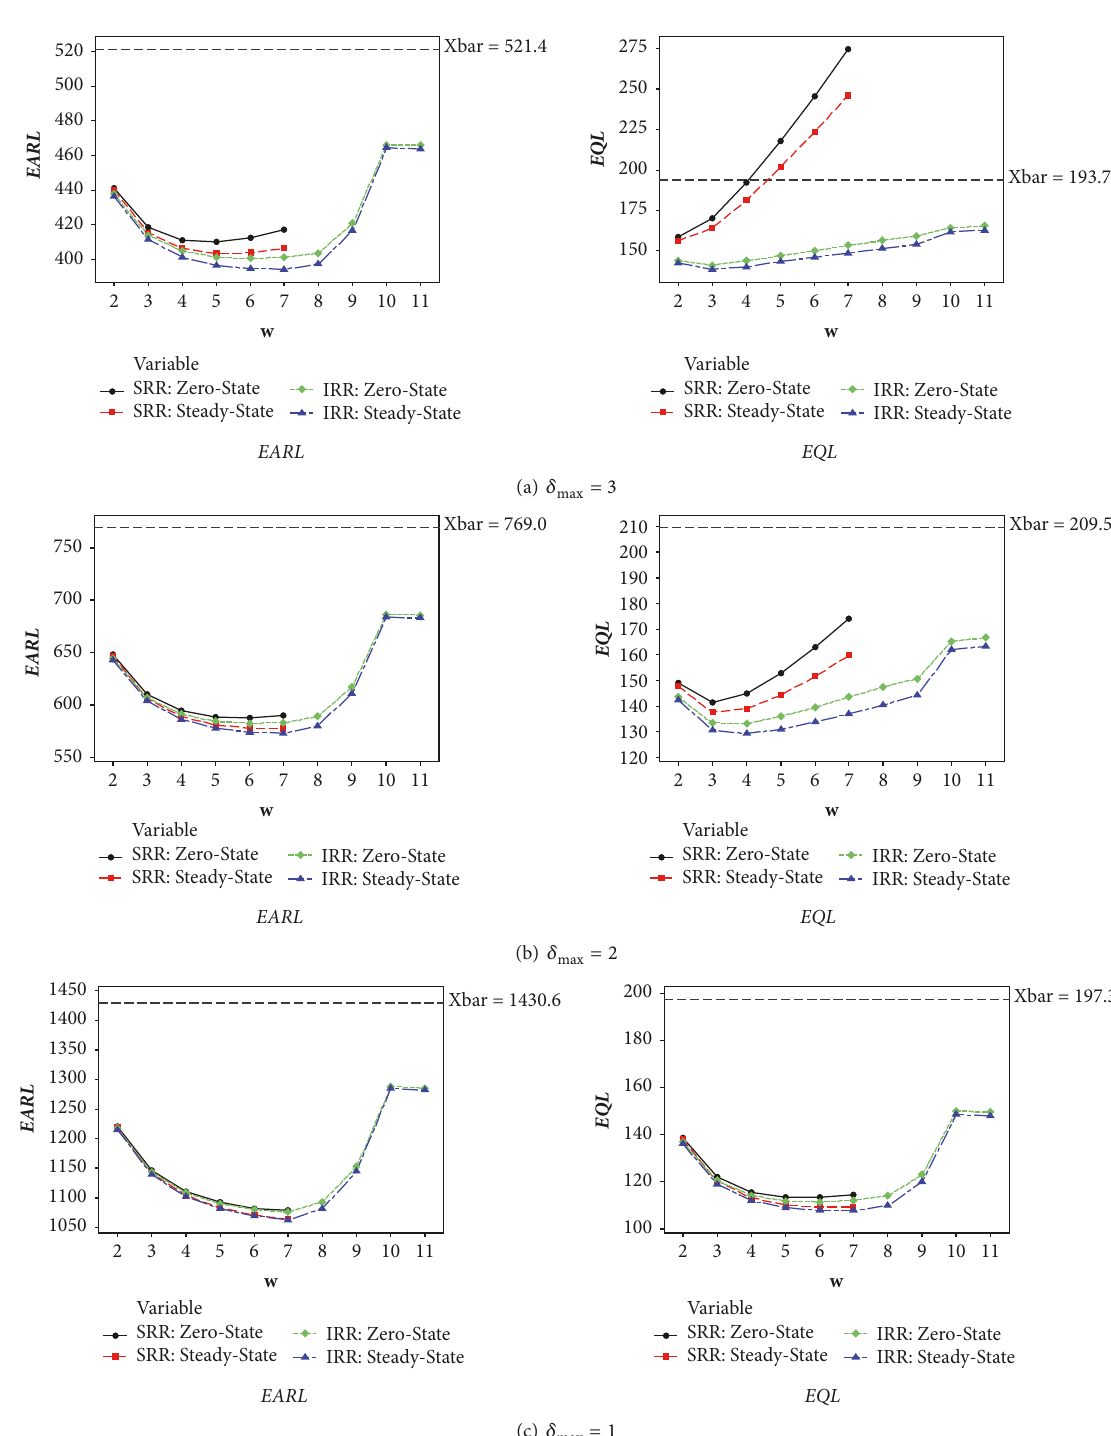
(continuous monitoring using the parameters estimated in Phase I); see the book by Chakraborti and Graham [23] for further discussion on these phases of application. Using